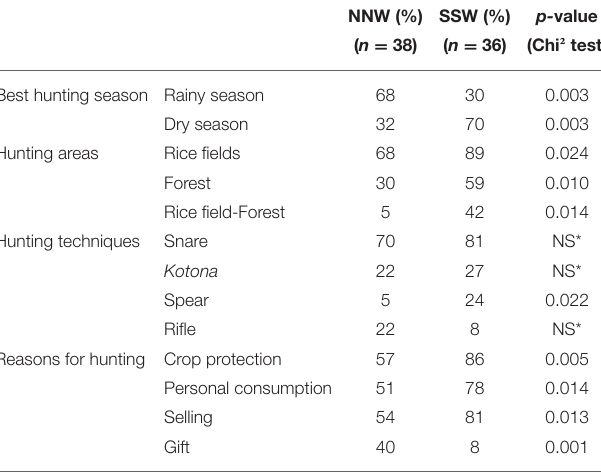
TABLE 2 | Modality and reason for hunting bushpigs during a survey on health and socioeconomic aspects of bushpig hunting in Madagascar, 2014–2015. NNW (%) SSW